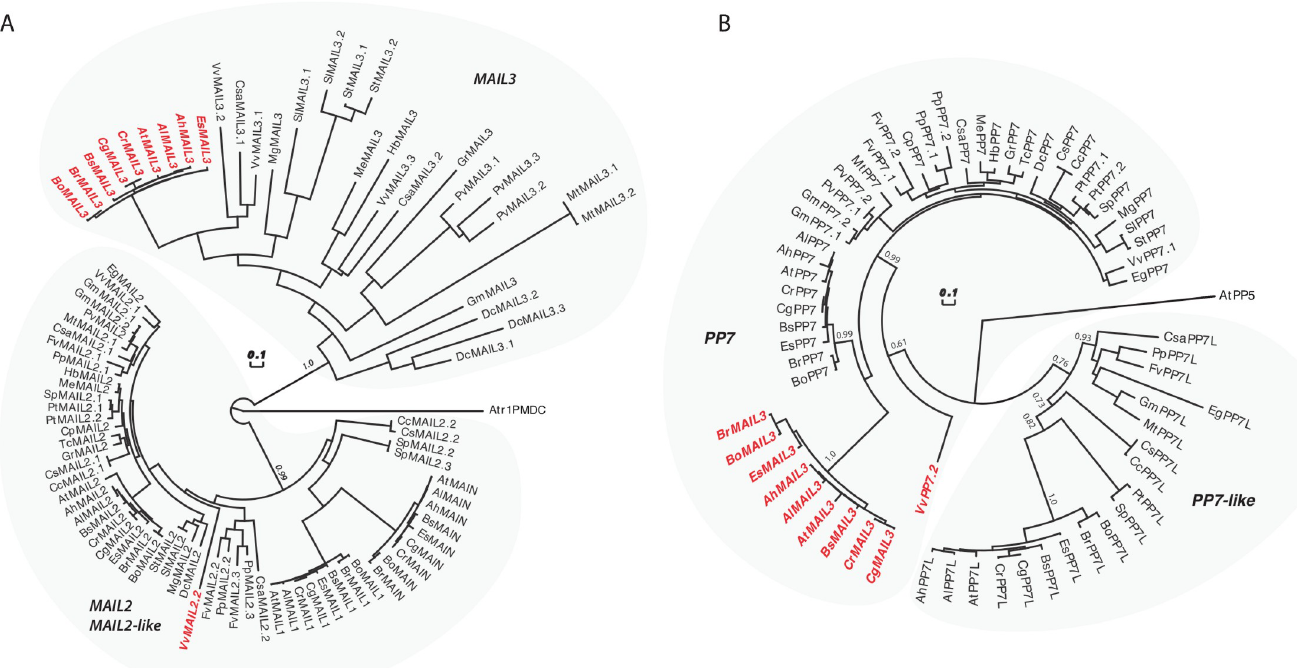
Fig 8. Evolutionary history of PMD-C and PP7 proteins in plants. (A) An alignment of the PMD-C motifs from 30 representative Eudicot species was used to construct a phylogenetic tree. The two major clades (MAIL2/MAIL2-like and MAIL3) are indicated. The species codes are given in S11 Table, and corresponding protein sequences in S12 Table). In red are genes presenting a fusion between a PMD-C and a PP7 motif. Statistical supports of key nodes calculated with the approximate likelihood-ratio test are indicated. Scale bar indicates one substitution/site. The tree was rooted using the Amborella trichopoda PMD-C motif (Atr1PMDC). (B) Phylogenetic tree constructed using an alignment of the PP7 motif from the same species as in (A). The two major clades (PP7 and PP7L) are indicated. In red are genes presenting a fusion between a PP7 and a PMD-C motif. Statistical supports of key nodes calculated with the approximate likelihood-ratio test are indicated. Scale bar indicates one substitution/site. The tree was rooted using the A . thaliana PP5 motif (AtPP5).